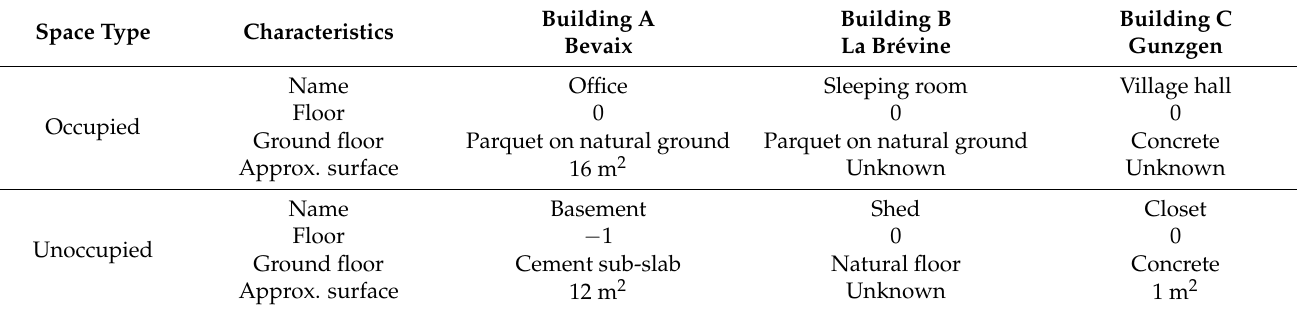
Table 6. Built characteristics of studied